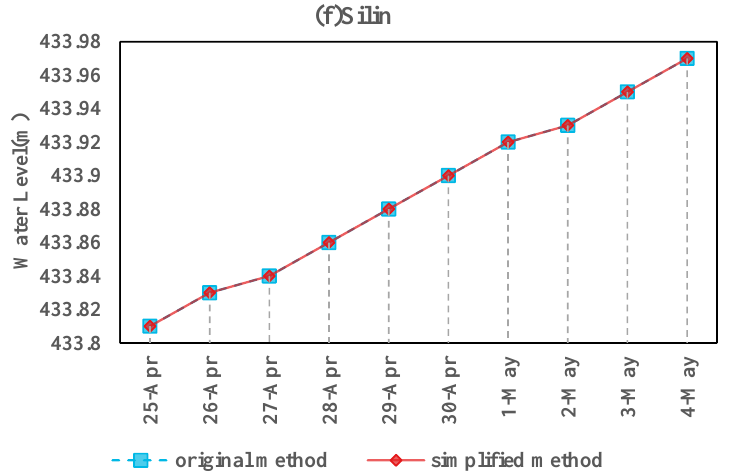
Figure 5. The Water Level Process of Each Reservoir in Wujiang River Obtained by the Simplified Solution Method and the Original Solution Method.